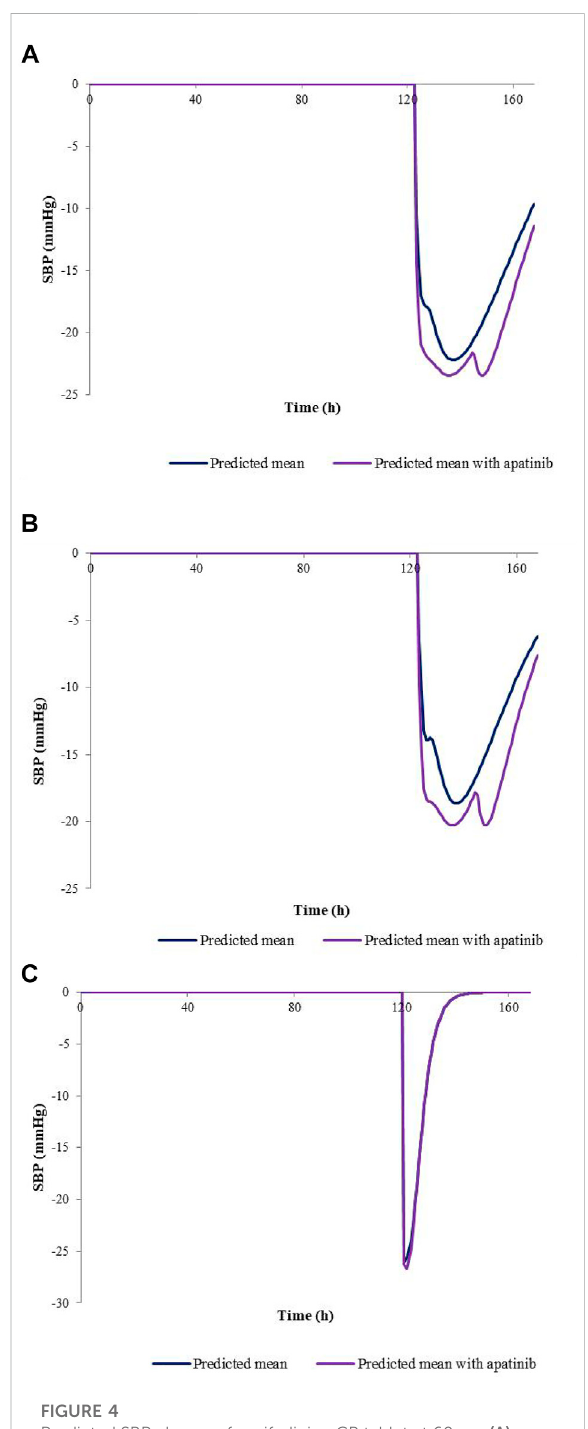
FIGURE 4 Predicted SBP changes for nifedipine CR tablet at 60 mg (A) , 30 mg (B) doselevels,andIRtabletat30 mg (C) doselevelswithor without co-administration of apatinib in cancer